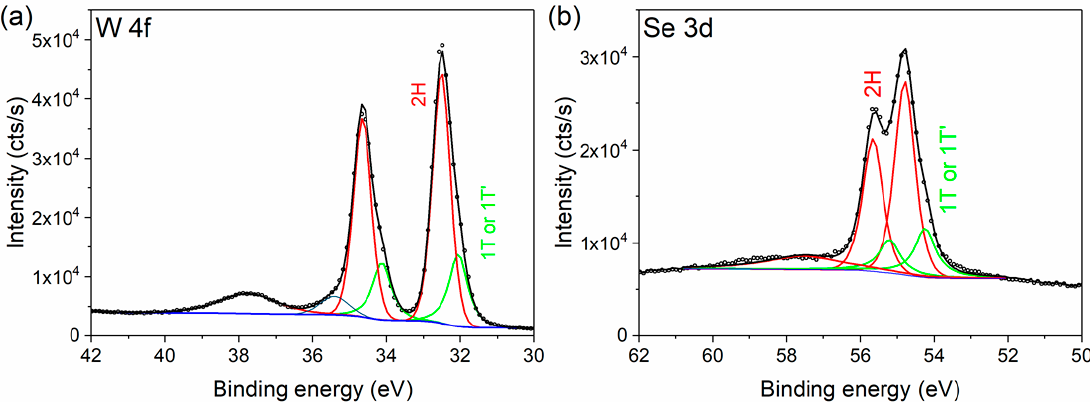
Figure 7. XPS spectra of the ( a ) W 4f and ( b ) Se 3d of the WSe 2 nanosheets.